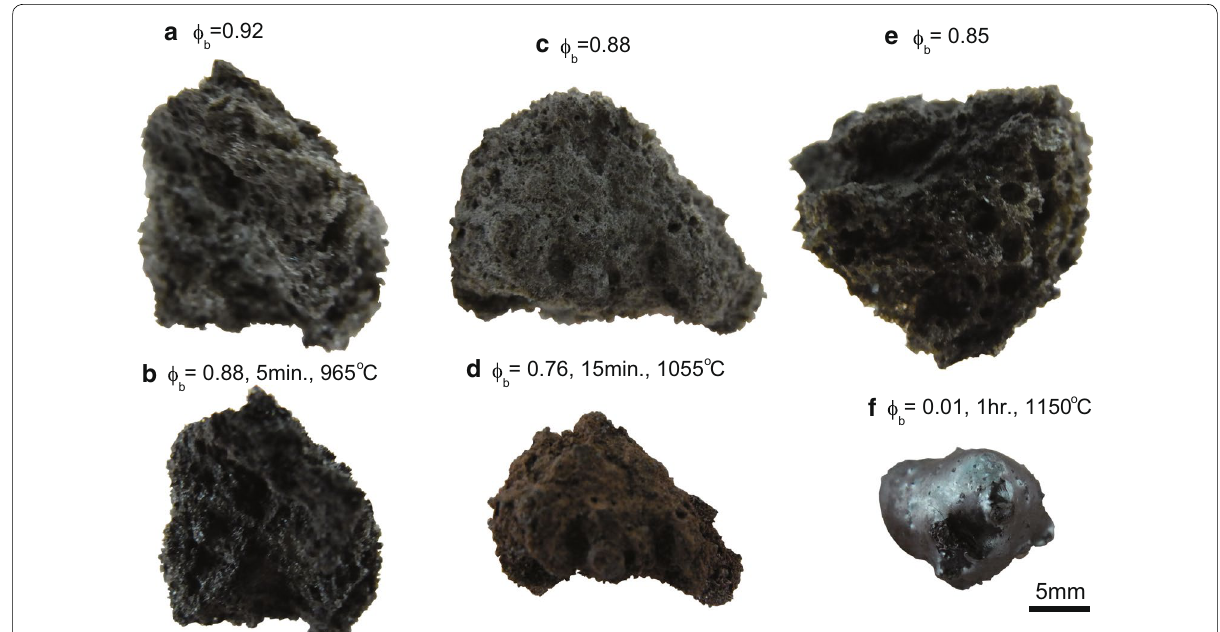
Fig. 4 Photographs of scoriae shrunk by heating. a , c , e and b , d , f show the photographs and porosities of scoriae before and after heating, respectively. Initially, the muffle furnace is kept at 1150 °C. When we open the furnace to place the samples inside, the internal temperature drops. We include this recovery time in the heating time